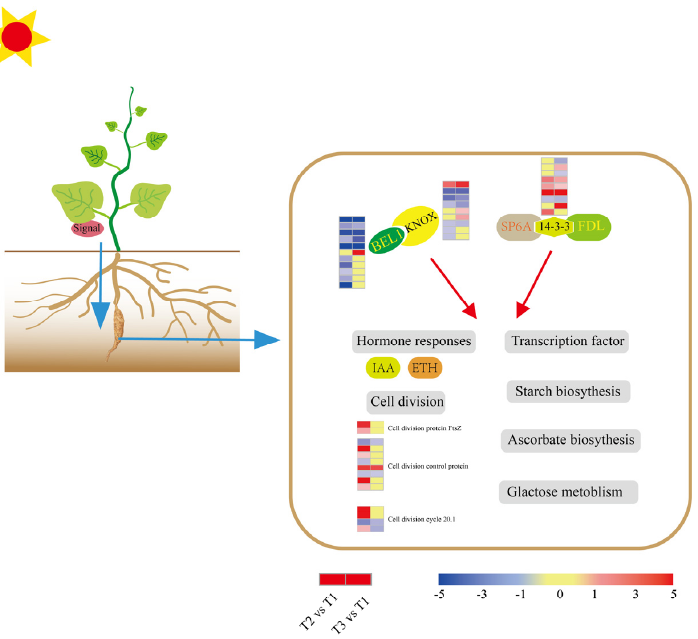
Figure 9. Model of the tuber signaling network. The expression heat maps from left to right are T2 vs. T1 and T3 vs.